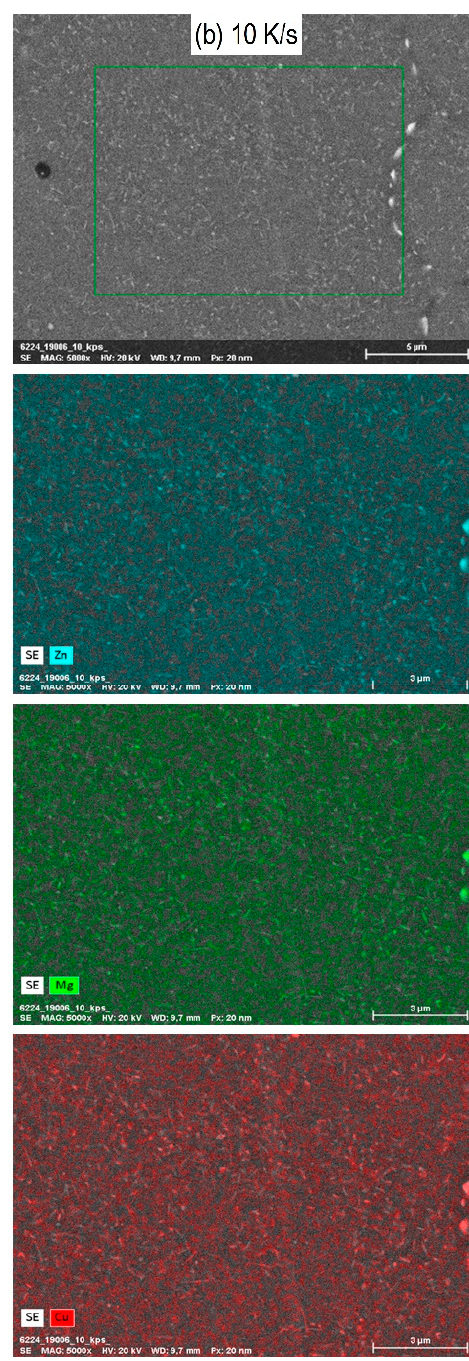
Figure 10. SEM-secondary electron images of alloy 7068: Cooling rates ( a ): 0.01 K/s; ( b ): 0.1 K/s; ( c ) 1 K/s; and ( d ) 10 K/s.